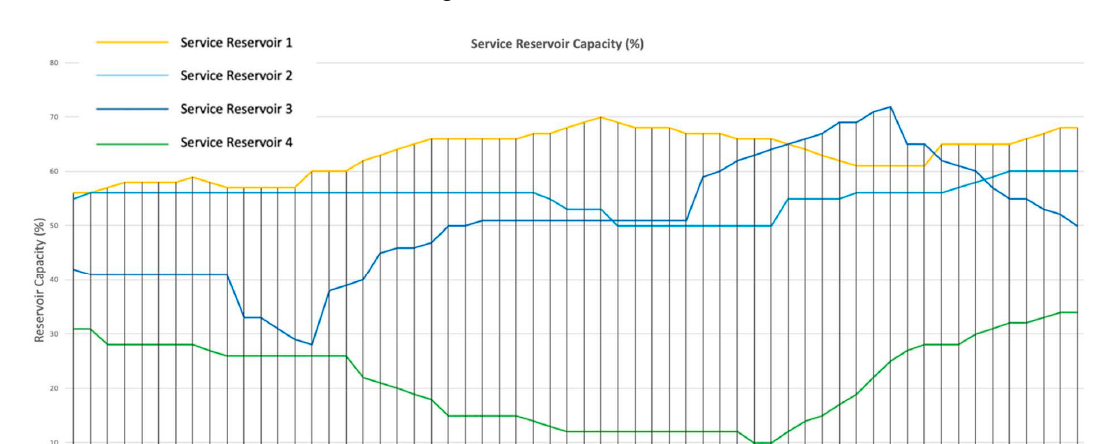
Figure 13. Simulink model.